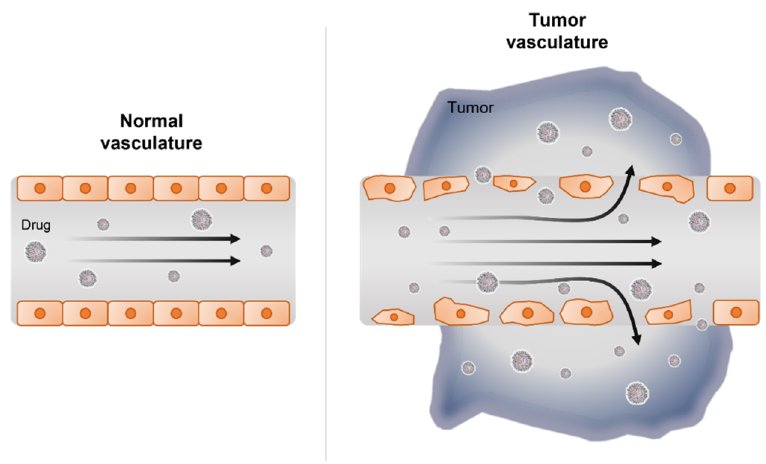
Figure 2. Drug delivery in vasculature of normal and tumor tissue.